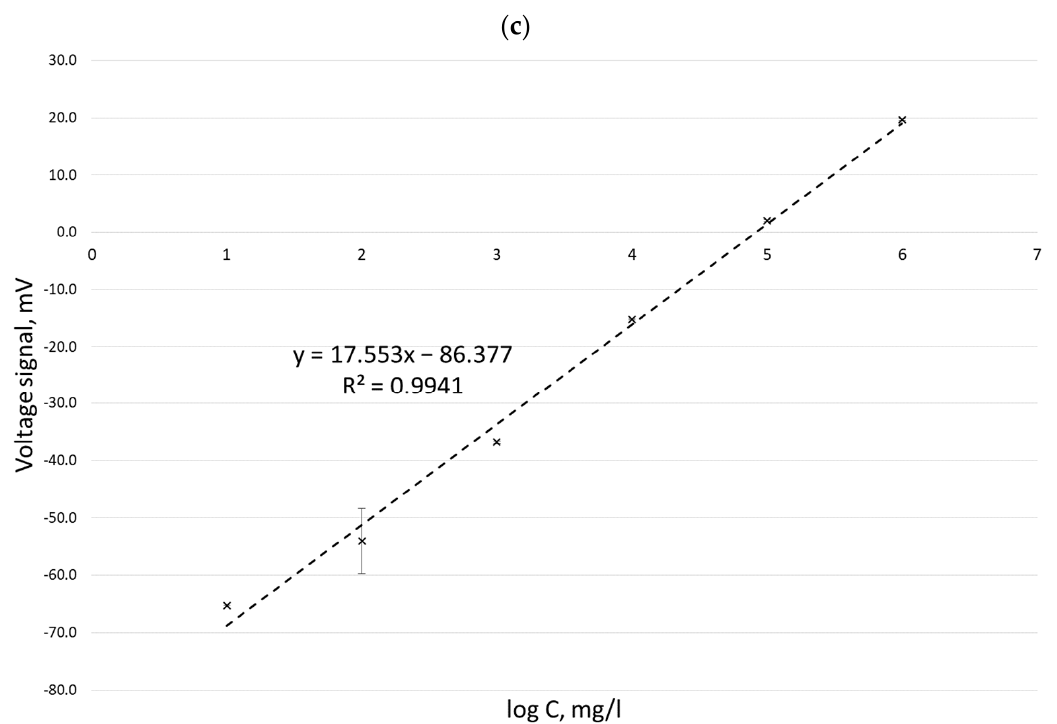
Figure 1. Calibration curves for the determination of potassium ion concentration by the ISE method in three different measurement series: 10 March 2022 ( a ), 11 March 2022 ( b ), and 14 March 2022 ( c ). Calibration curves obtained for potassium ion concentrations ranging from 1 to 25 mg/L by the MIP-OES method for two different wavelengths are shown in Figure 2.